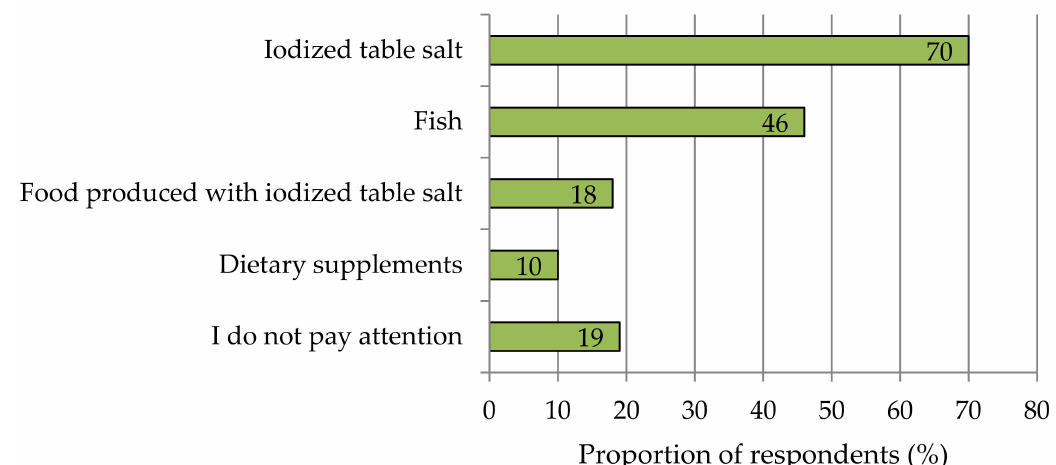
Figure 2. Products currently used to prevent possible iodine deficiency. Multiple answers were allowed. n = 1016.